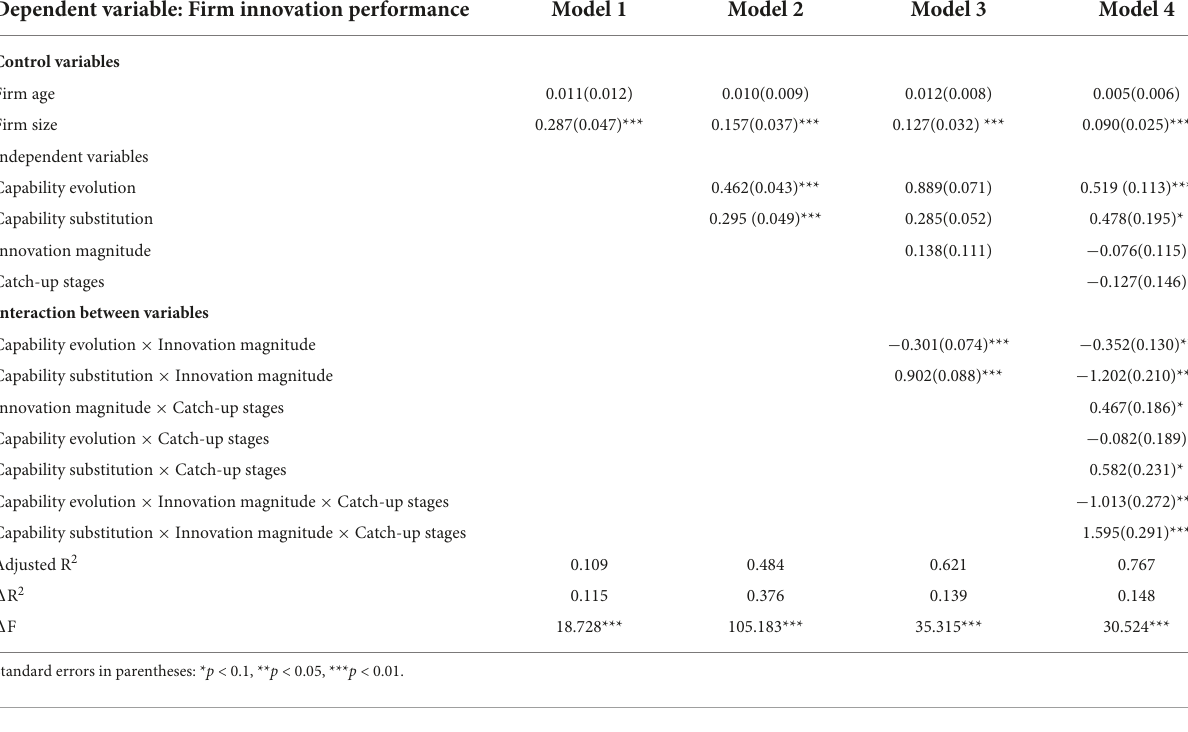
TABLE 4 Results of hierarchical linear regression analysis for firm innovation performance.